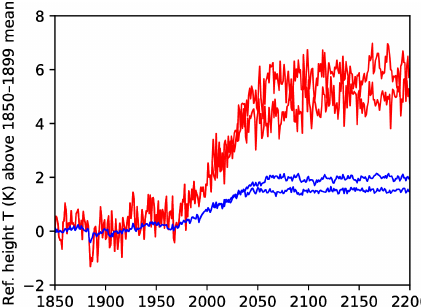
Figure 7. Time evolution of global-mean near-surface tempera- ture for Hist1 (1850–2005) and CPL-15 and CPL-20 (2005–2200) from NorESM1-Happi relative to the 1850–1899 average. Fields are shown for the global average (blue) and for an average taken over the area north of 65 ◦ N (red), i.e. approximately 4.7% of the global area. Units are in